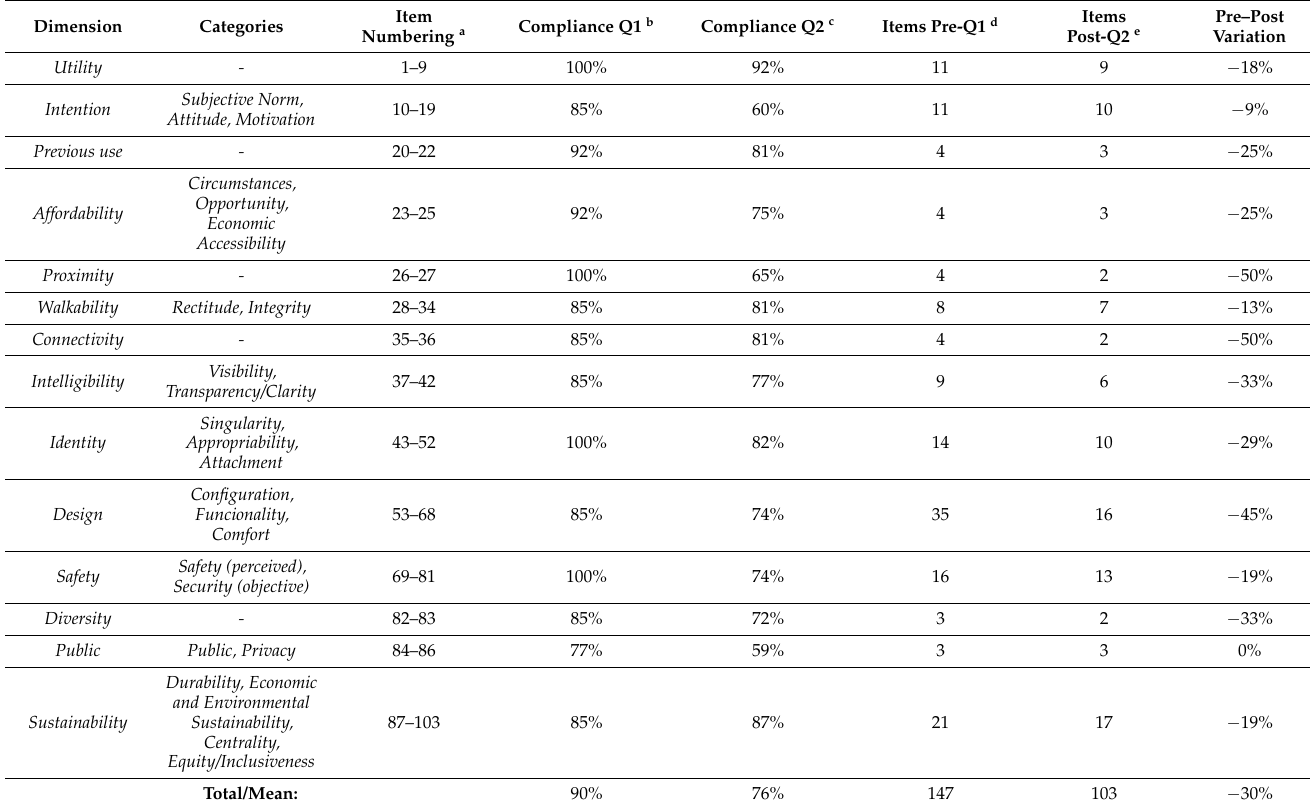
Table 3. Dimensions, categories and number of items in the final instrument. Consensus and variation before and after the Delphi panel.